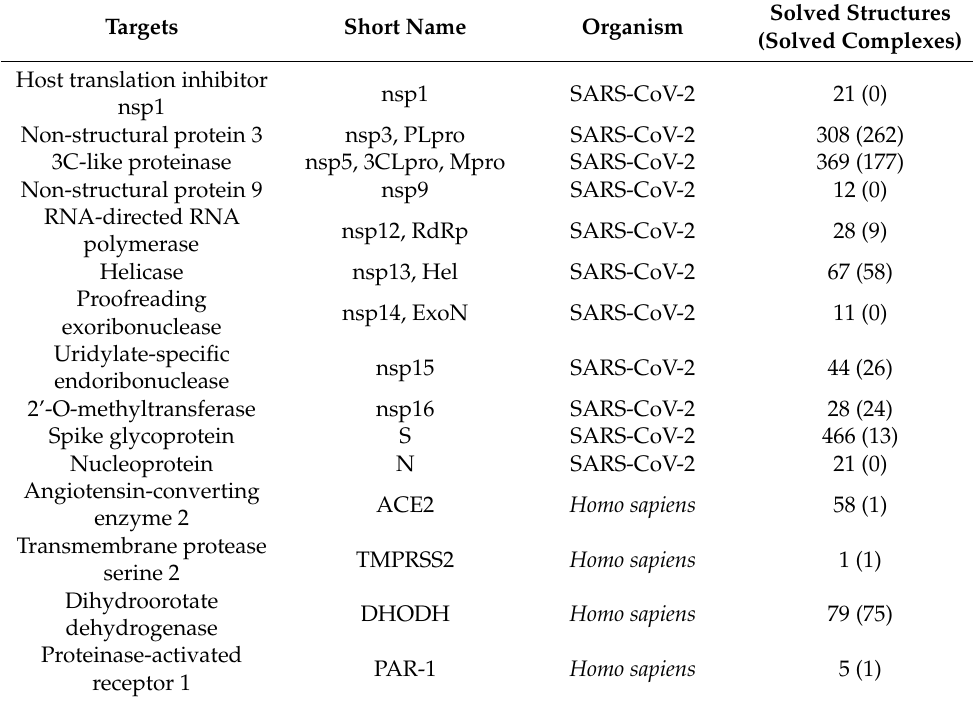
Table 1. The main drug targets for the treatment of SARS-CoV-2 used in CADD studies. Targets Short